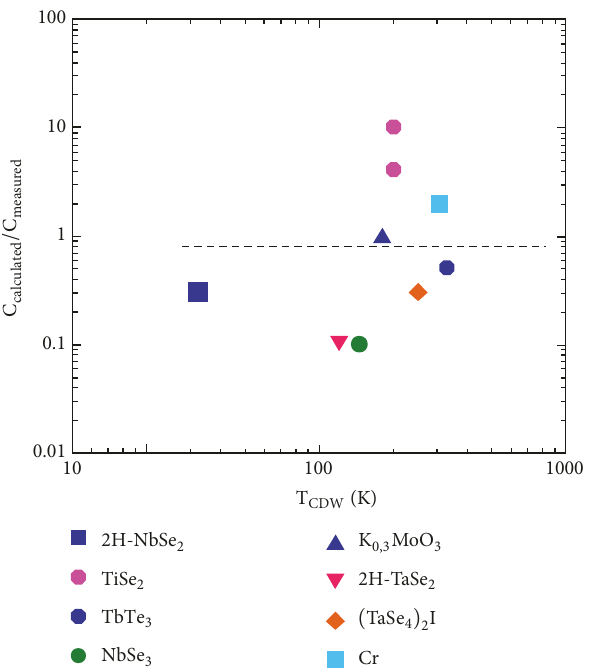
Figure 6: Color on line . Temperature dependence of the measured relative velocity (cid:2) V/V as a function of the reduced temperature T / T CDW . Velocity of the longitudinal mode in the (a b) plane in TiSe 2 [20], 2H-TaS 2 [16, 17], 2H-NbSe 2 [16, 17], and TTF-TCNQ [36]. Velocity of the mode C 33 measured with ErTe 3 at the upper CDW phase transition T = 260 K [42]. The dashed curves are CDW calculated with the BCS theory (see